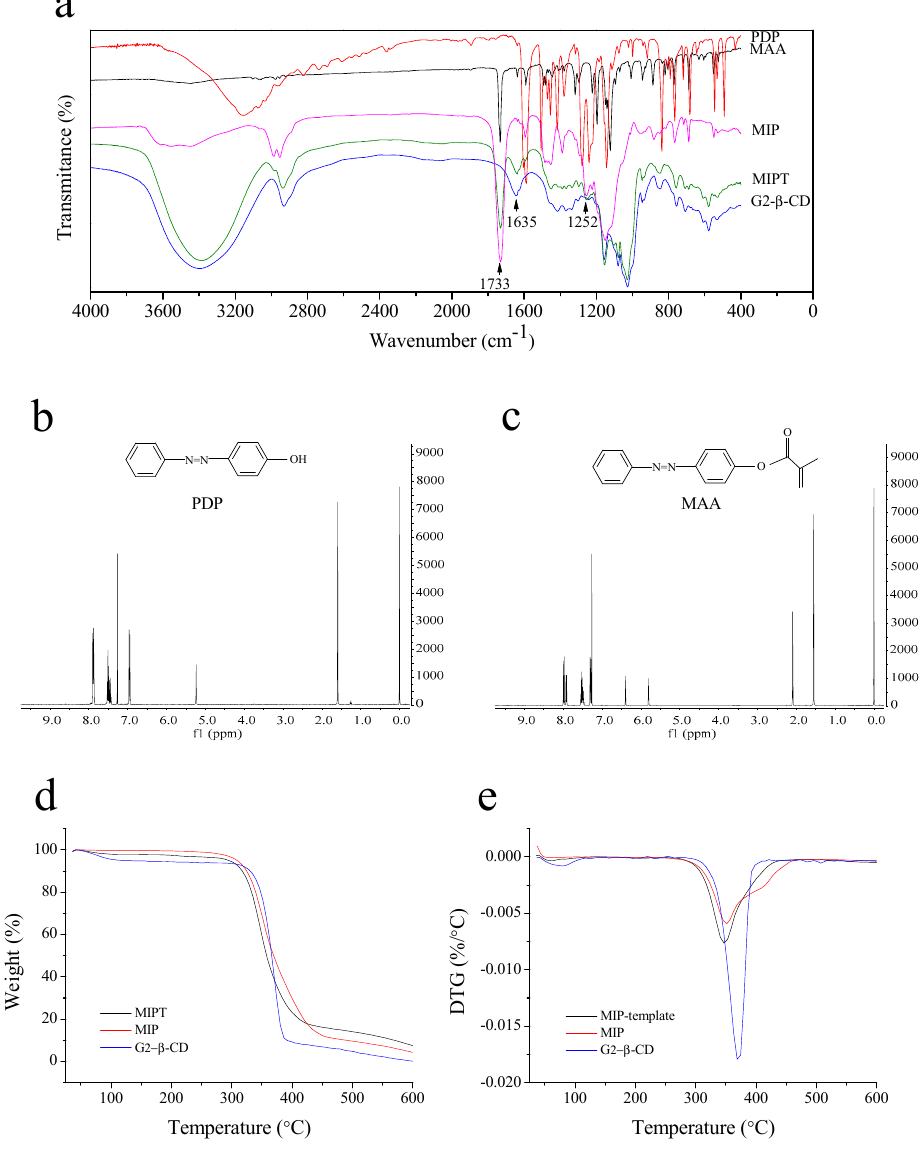
Figure 2. Fourier transform infrared spectroscopy (FTIR), thermogravimetric analysis (TGA) and 1 H-NMR spectrum. ( a ) FTIR spectra; ( b ) 1 H-NMR spectrum of 4-(Phenyldiazenyl)phenol (PDP); ( c ) 1 H-NMR spectrum of MAA; ( d ) TGA thermograms; ( e ) derivative thermogravimetry (DTG) thermograms.